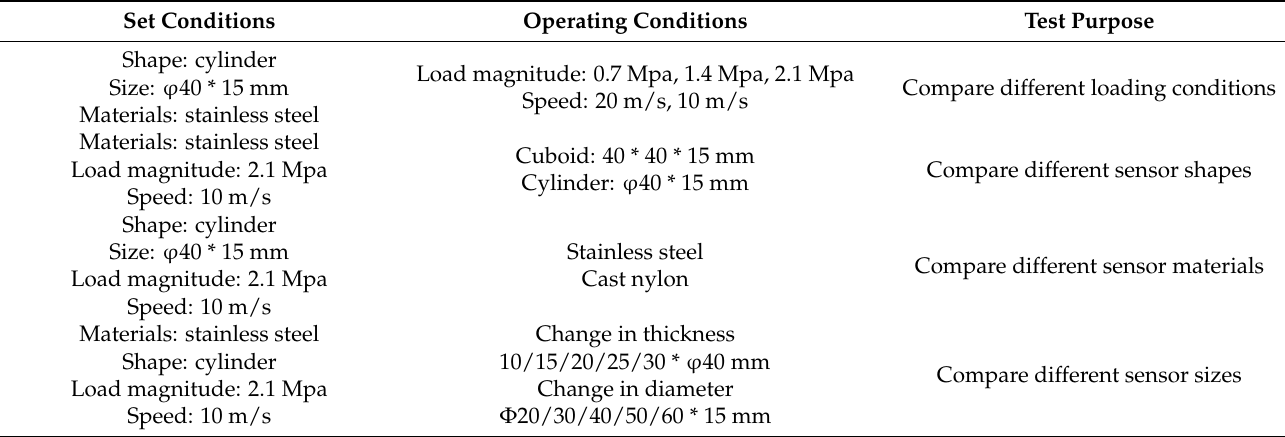
Table 4. Multiple working conditions.